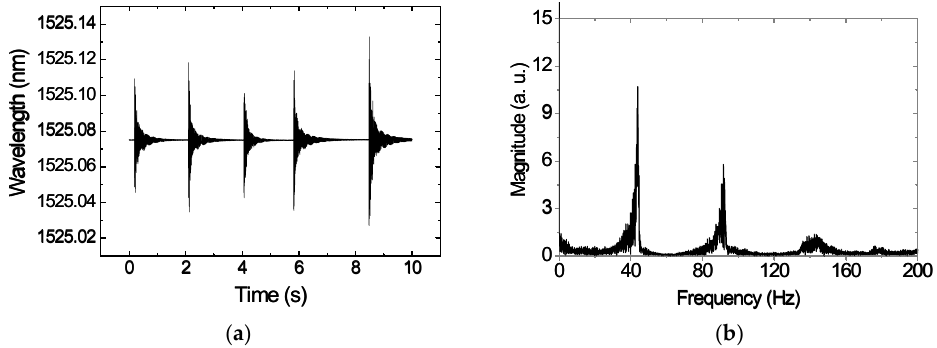
Figure 5. ( a ) Sensor 1 response to the application of five vertical impacts, 48 h after applying the 0.1 M NaCl solution; ( b ) corresponding frequency spectrum after FFT processing.